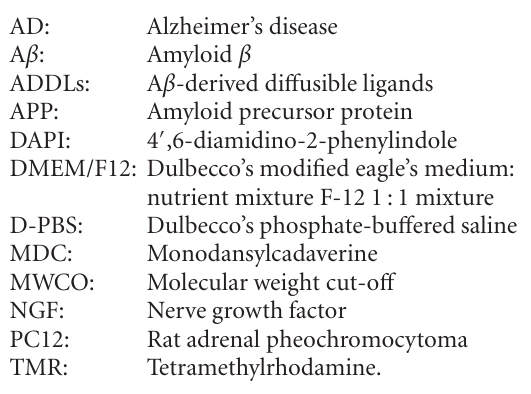
Figure 11: A plausible mechanism of A β